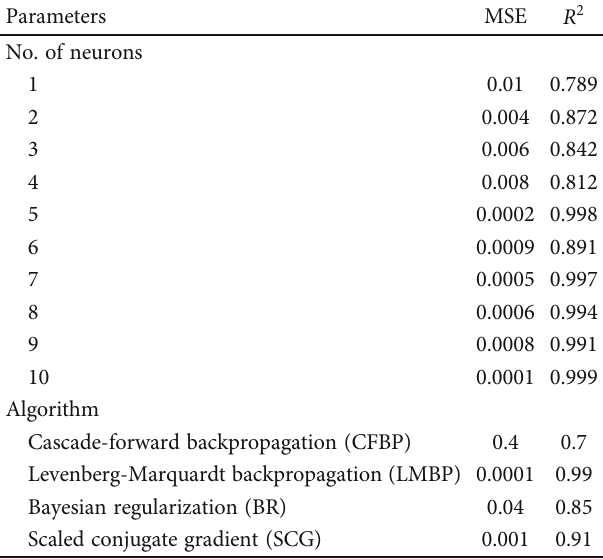
Table 3: Performance evaluation of ANN based on number of neurons and